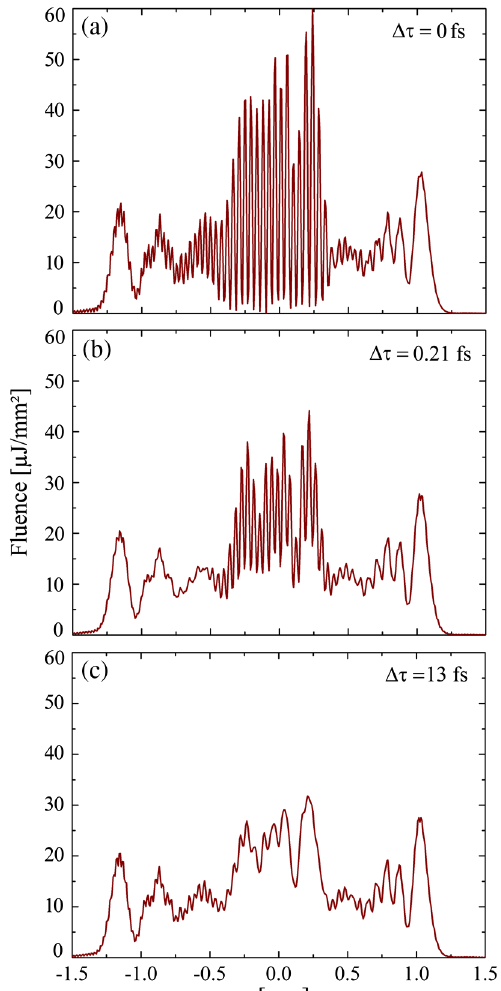
FIG. 8. Vertical cuts through the interference patterns for nonperfect mirrors for zero delay (a) for τ ¼ 0 . 21 fs (b) and for τ ¼ 13 fs